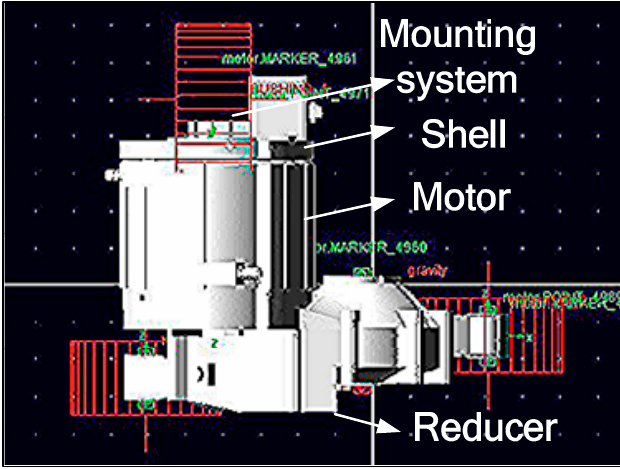
Figure 2. Power train mounting system by ADAMS.